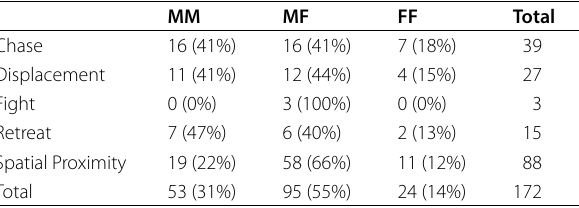
Table 4 Frequency and percent of each type of interaction for